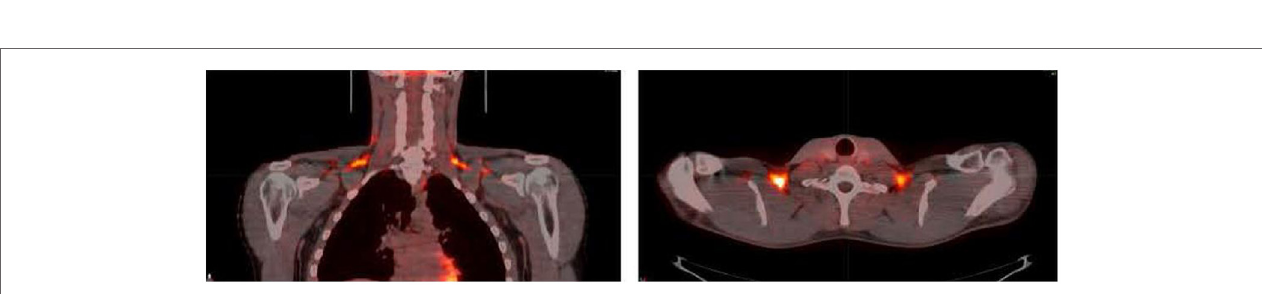
FiGURe 1 | Schematic overview of mitochondrial energy transduction within a brown adipocyte mitochondrion . Norepinephrine (NE) activation of adrenergic receptors (AR) causes an increase in cytosolic cyclic adenosine monophosphate (cAMP) levels. The subsequent activation of lipases results in the lipolysis of triacylglycerol (TAG), which increases intracellular free fatty acid (FFA) concentrations. FFAs fulfill two principal metabolic fates: (i) FFAs bind to and activate uncoupling protein 1 (UCP1), thus switching on UCP1-mediated proton (H + ) conductance. (ii) Activated FFAs (acyl-CoA) can be transported into the mitochondrion via the carnitine palmitoyl transferase (CPT) system and be oxidized to acetyl-CoA, thereby potentiating anaplerosis and providing reducing equivalents for the electron transport chain (ETC). Pyruvate also participates in mitochondrial anaplerosis and the production of reducing equivalent by being decarboxylated to acetyl-CoA by pyruvate dehydrogenase (PDH) or being carboxylated by pyruvate carboxylase (PC), forming oxaloacetate